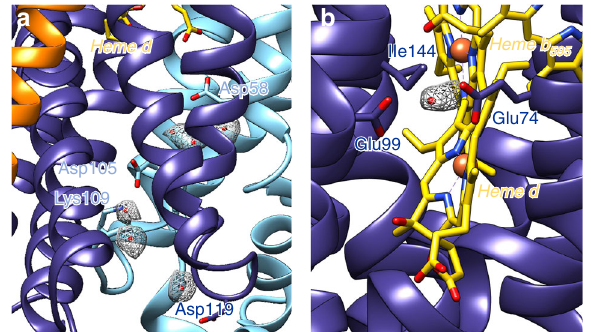
Fig. 4 Water densities within bd oxidase. a A chain of water molecules at the subunit interface was identi fi ed providing a proton path from the cytosol to Asp58 on CydB. Protons can be transferred from this residue to the propionate of heme d. b A density between Glu99 and Glu74 close to heme d could be caused by the substrate dioxygen or the product water. CydA is shown in dark blue, CydB in light blue and CydX in orange.